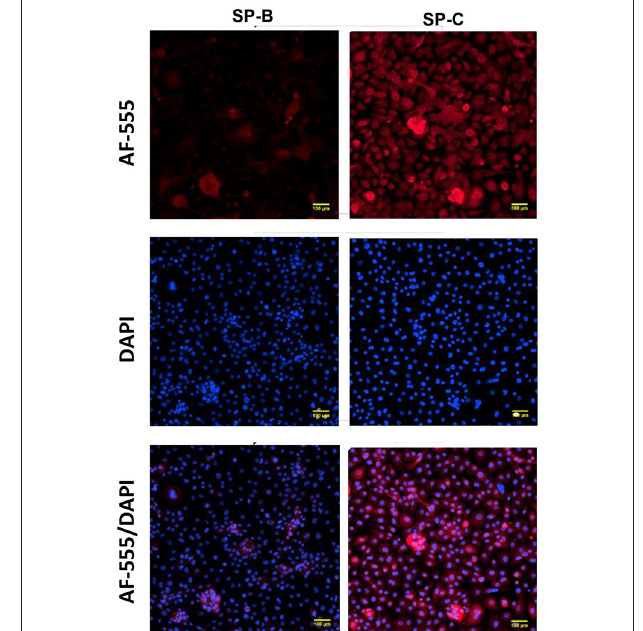
FIGURE 2 | Expression of ABCA-3 in primary nasal epithelial cells. Expression of ABCA-3 was assessed in formaldehyde-fixed primary nasal epithelial cells cultured in chamber slides and visualized by fluorescent microscopy at 100 × total magnification. ABCA-3 was detected in primary nasal cells with a diffuse pattern of expression in the cytoplasm. DAPI was used as a nuclear stain. Scale bar 100 µ m. Representative images are shown.